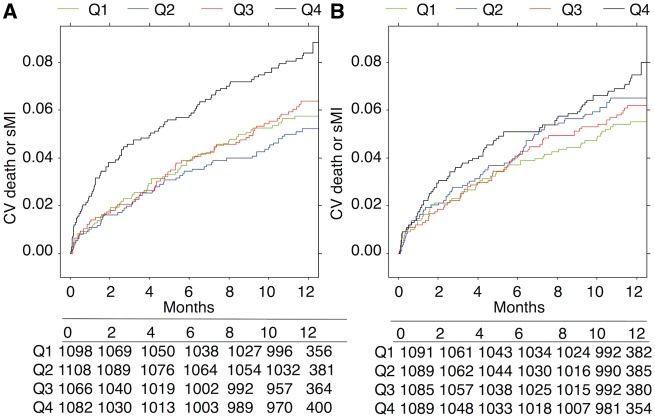
Relationship between fibrin clot parameters and 1-year cumulative event rate of cardiovascular death or spontaneous myocardial infarction. The Kaplan–Meier curves for cumulative event rate of the combined outcome of cardiovascular death or spontaneous myocardial infarction per quartile group of lysis time (A) and maximum turbidity (B).